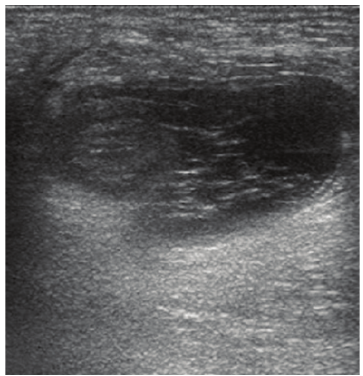
Figure 1: Preoperative ultrasound scan of right groin swelling showing a presumed indirect inguinal hernia containing one bowel loop and fatty omentum.